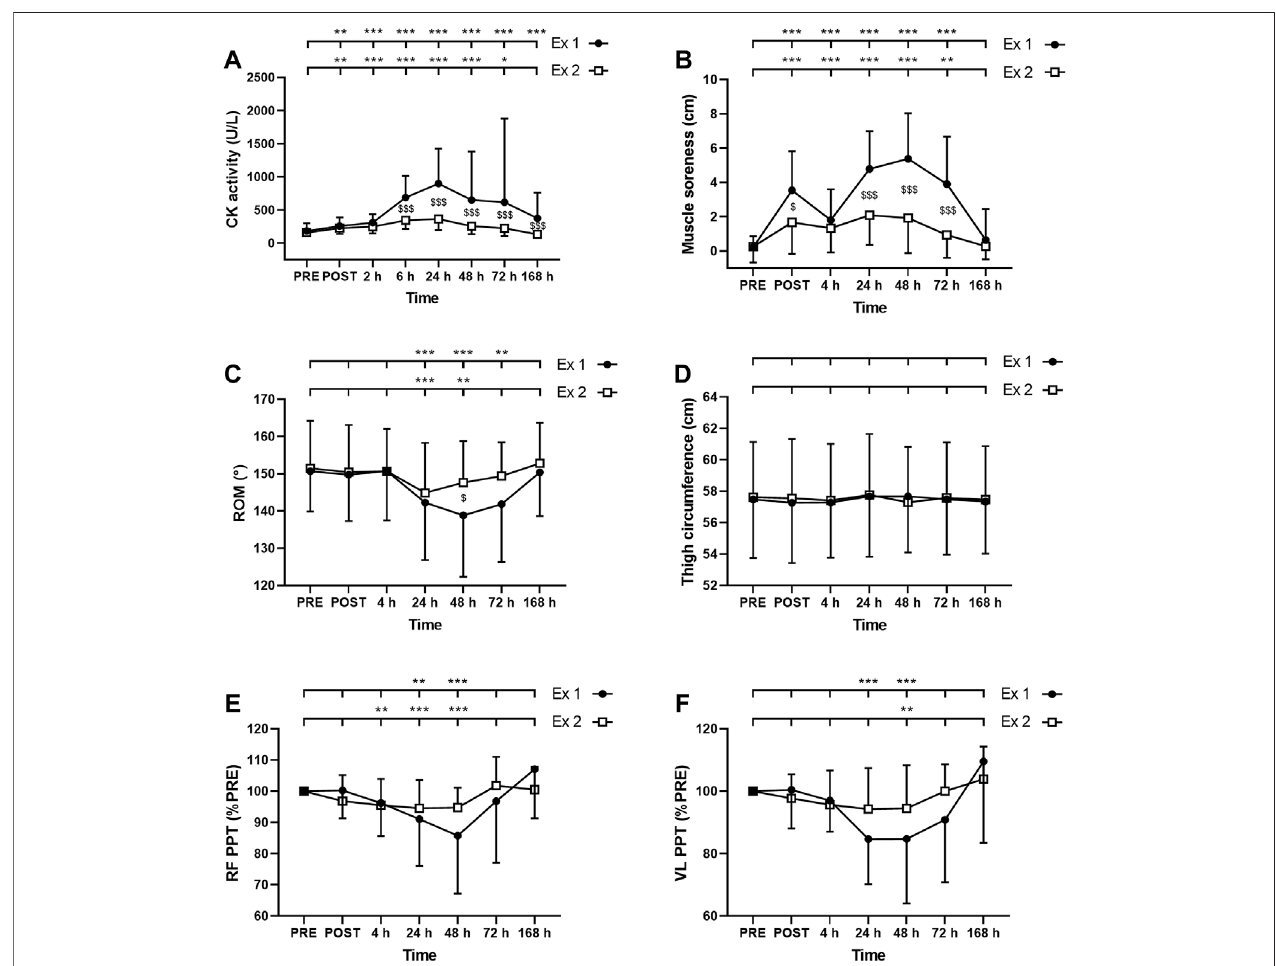
FIGURE 4 | Time course of (A) serum creatine kinase (CK) activity (B) muscle soreness (C) range of motion (ROM), thigh circumference (D) , and pain pressure threshold(PPT)for (E) rectusfemoris (RF)and (F) vastuslateralis (VL)forexercise1and2.*,**and***correspondtosigni fi cantdifferencefromPREvalueat p < 0.05, p < 0.01and p < 0.001,respectively.$,$$and$$$correspondtosigni fi cantdifferencebetweenexercise1andexercise2 at p < 0.05, p < 0.01and p < 0.001,respectively.